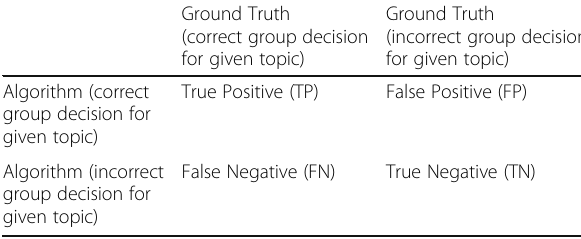
Table 5 Confusion matrix used for